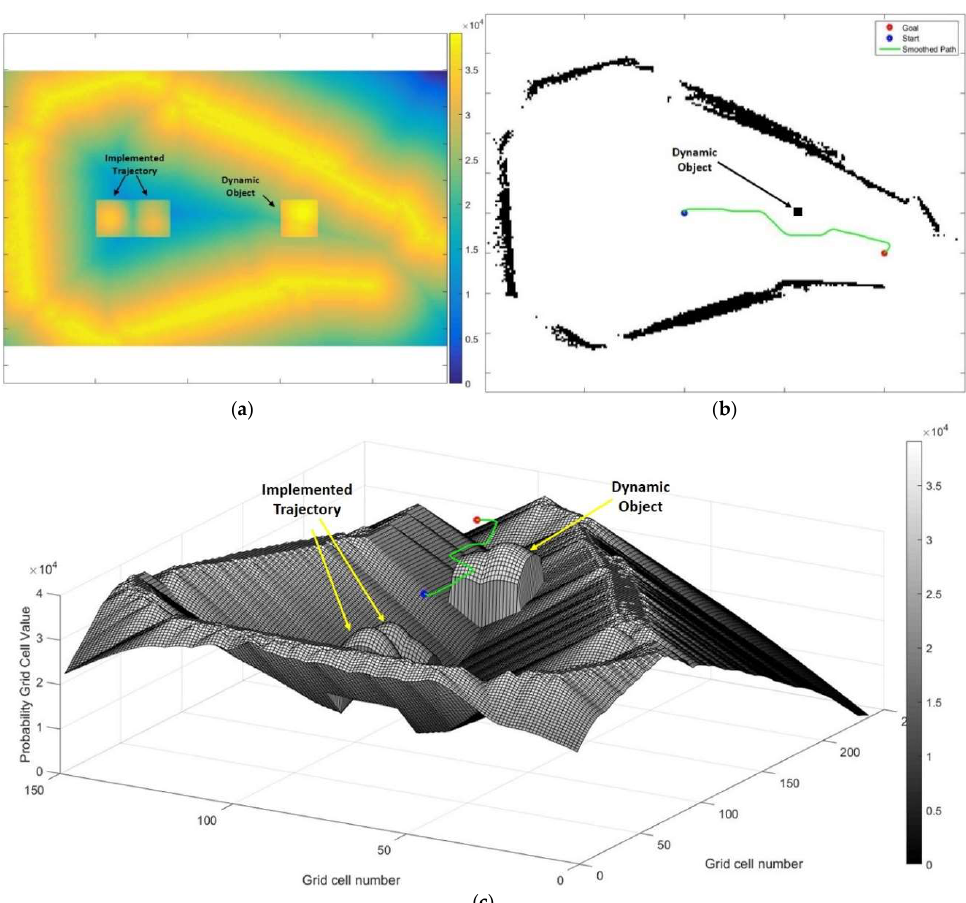
Figure 20. Adjusted A* algorithm in a dynamic environment: ( a ) cost map; ( b ) 2D representation; and ( c ) 3D representation. ( c ) 3D